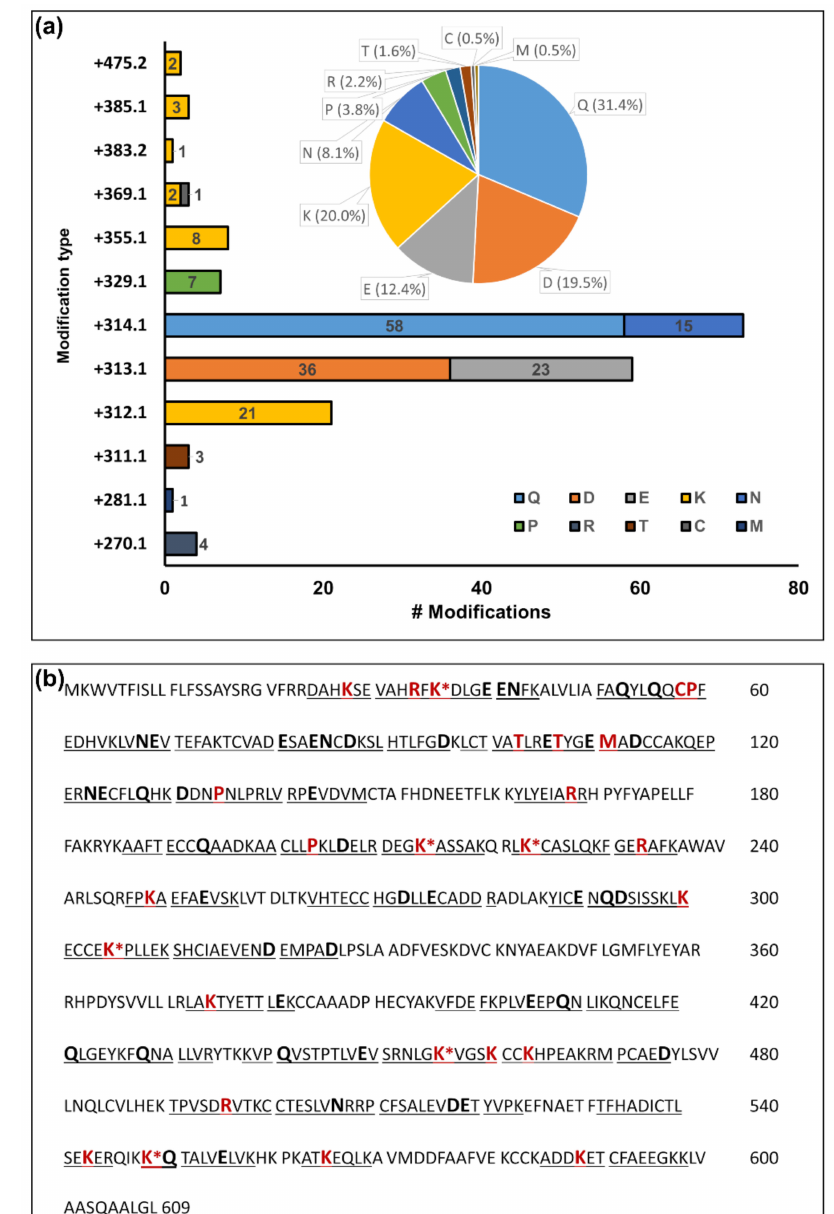
Table S3: “ARP-Plasma Upscale”). Modifications corresponding to 12 different mass shifts were detected at 10 amino acids (Figure 5a).